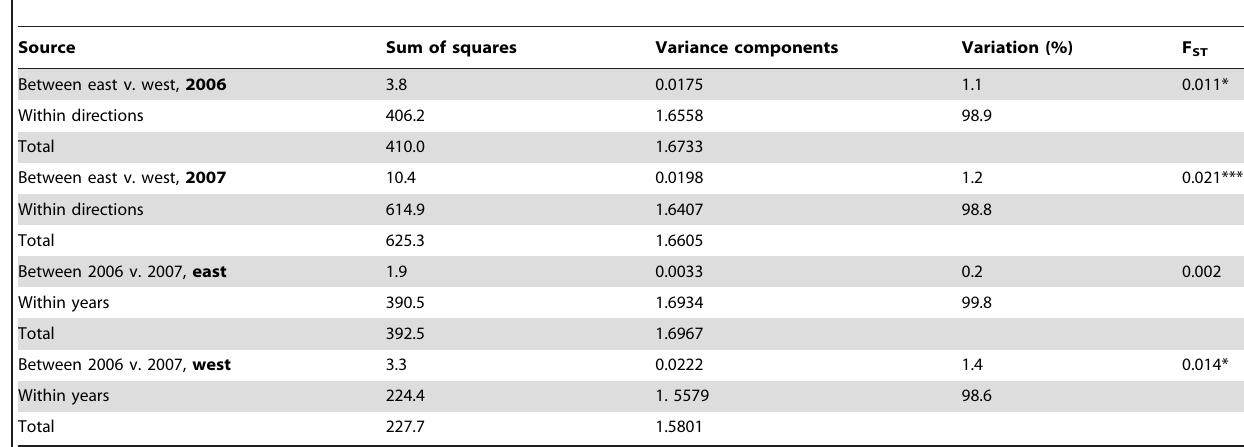
Table 3. Analysis of molecular variance using nuclear microsatellite and SNP